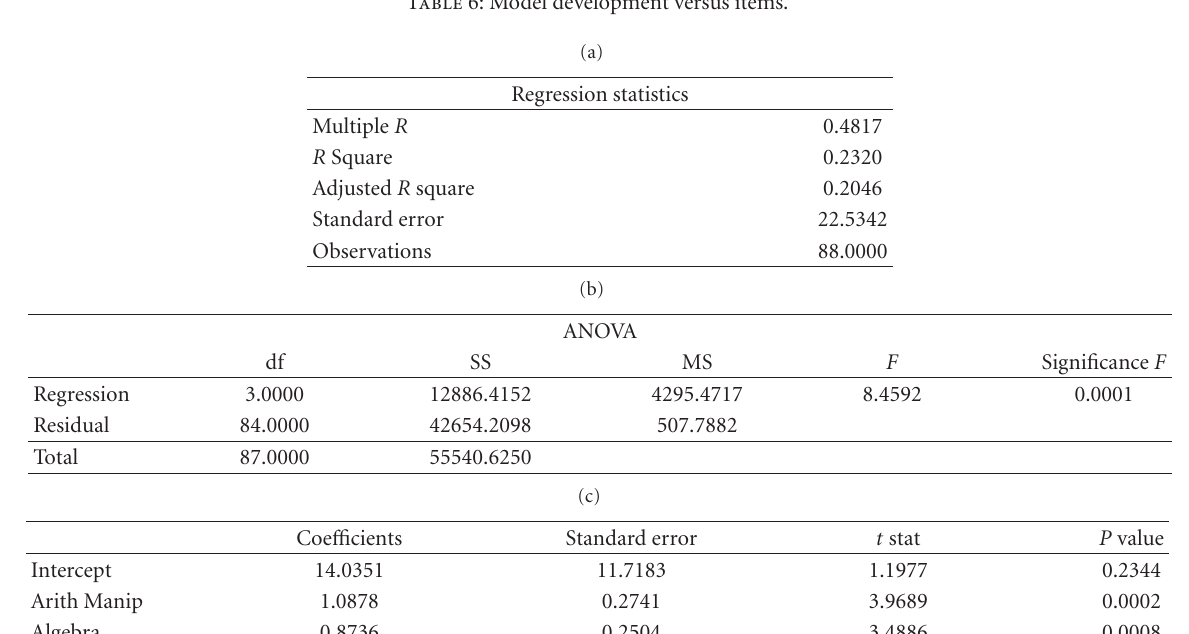
Table 6: Model development versus